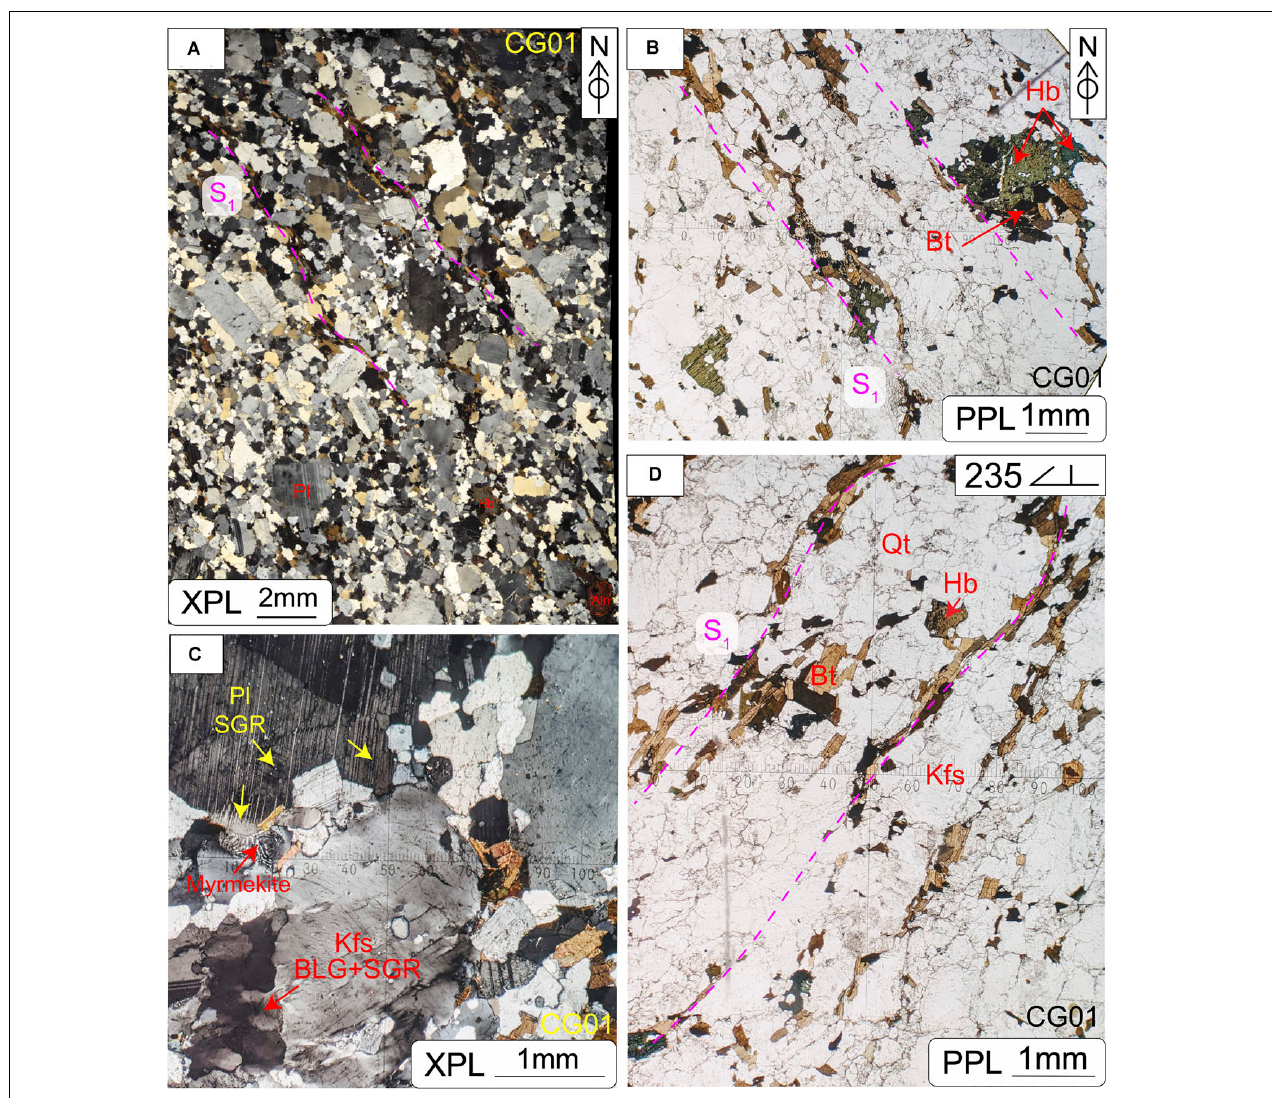
FIGURE 9 | Microphotographs showing microstructures and petrographic relationship of D 1 . (A) S 1 foliation defined by alignment of biotite, elongated quartz, and plagioclase. The weak development of foliation is due to the low percentage of biotite in the sample and the granoblastic interlobate texture developed in the granulite facies condition. (B) Myrmekite precipitated between the K-feldspar and plagioclase, which is post the granoblastic interlobate matrix of quartz and feldspar aggregates. The deformation mechanism is SGR and BLG for K-feldspar, and SGR for plagioclase. (C,D) Gneissic layering suggested by the biotite cleavage domain and the quartzofeldspathic microlithon domain. Hb-hornblende; Bt-biotite; Pl-plagioclase; Aln-allanite; SGR-subgrain rotation recrystallization;